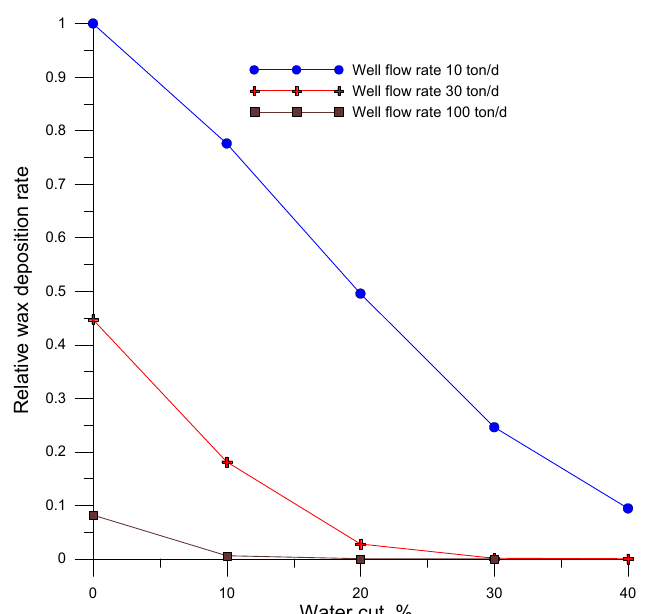
Figure 3. Influence of the water cut on the relative wax deposition rate, µ o = 10 mPa · s, C asph = 0.05, C o = 0.0546 .